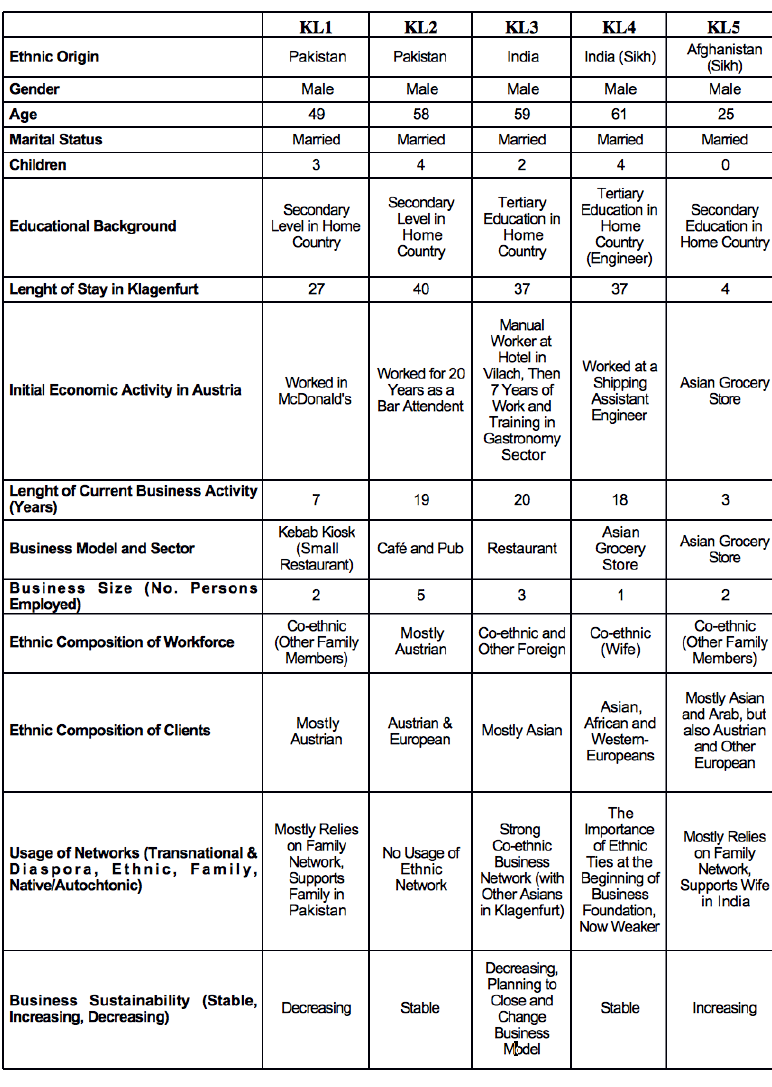
Table 2: Migrant Entrepreneurs in